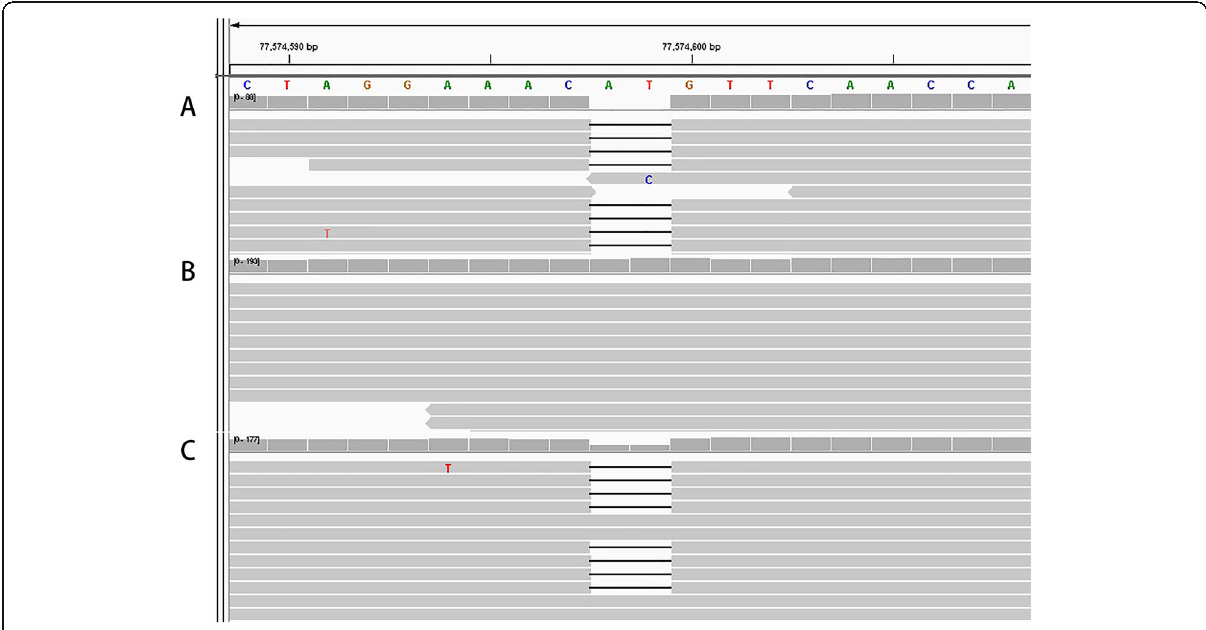
Fig. 2 The frameshift mutation was detected in the genomes of proband ( a ) and mother ’ s sample ( c ) but not in father ’ s sample ( b